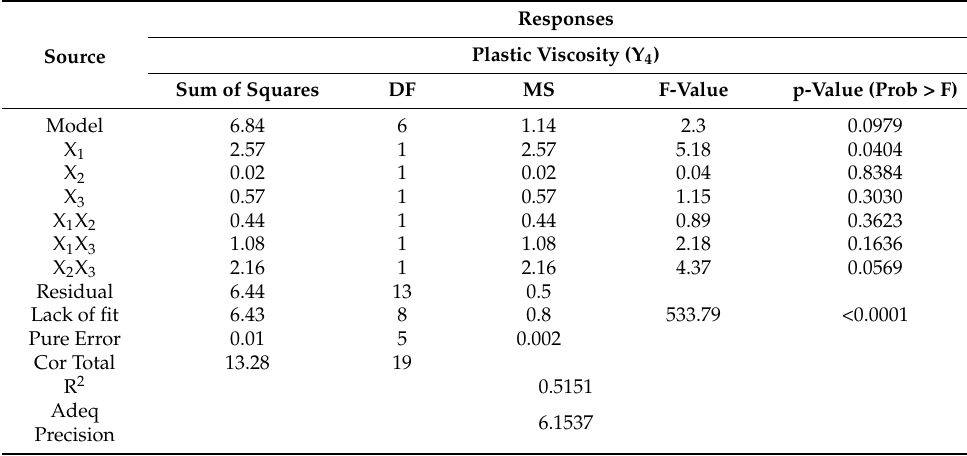
Table 8. Analysis of variance (ANOVA) of the response model of plastic